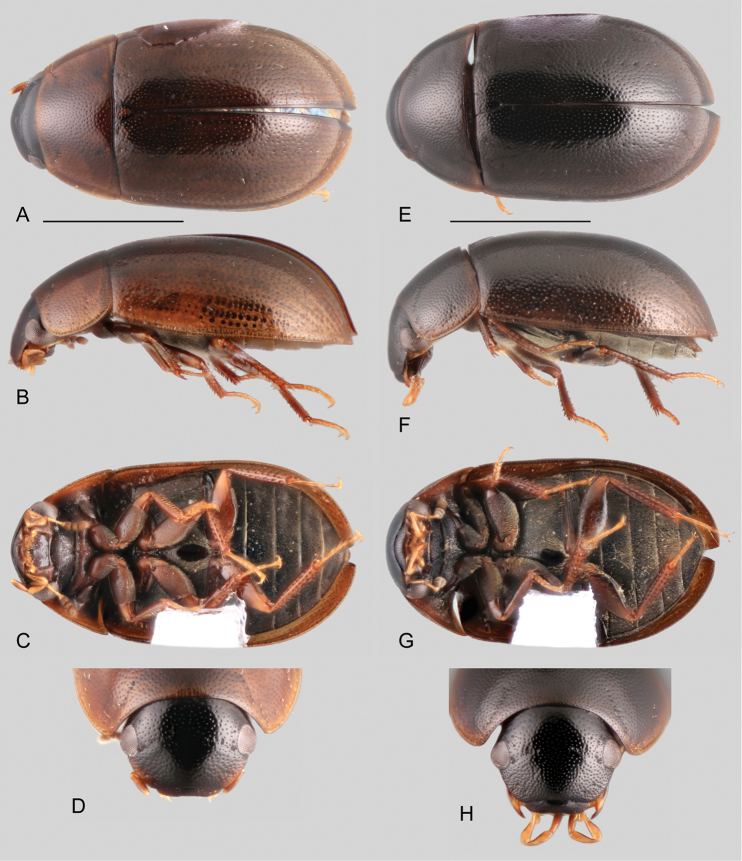
Habitus of Ephydrolithus spp.: A–DEphydrolithushamadae: A dorsal view B lateral view C ventral view D head, dorsal view. E–HEphydrolithusteli: E dorsal view F lateral view G ventral view H head, dorsal view. Scale bars: 1 mm.